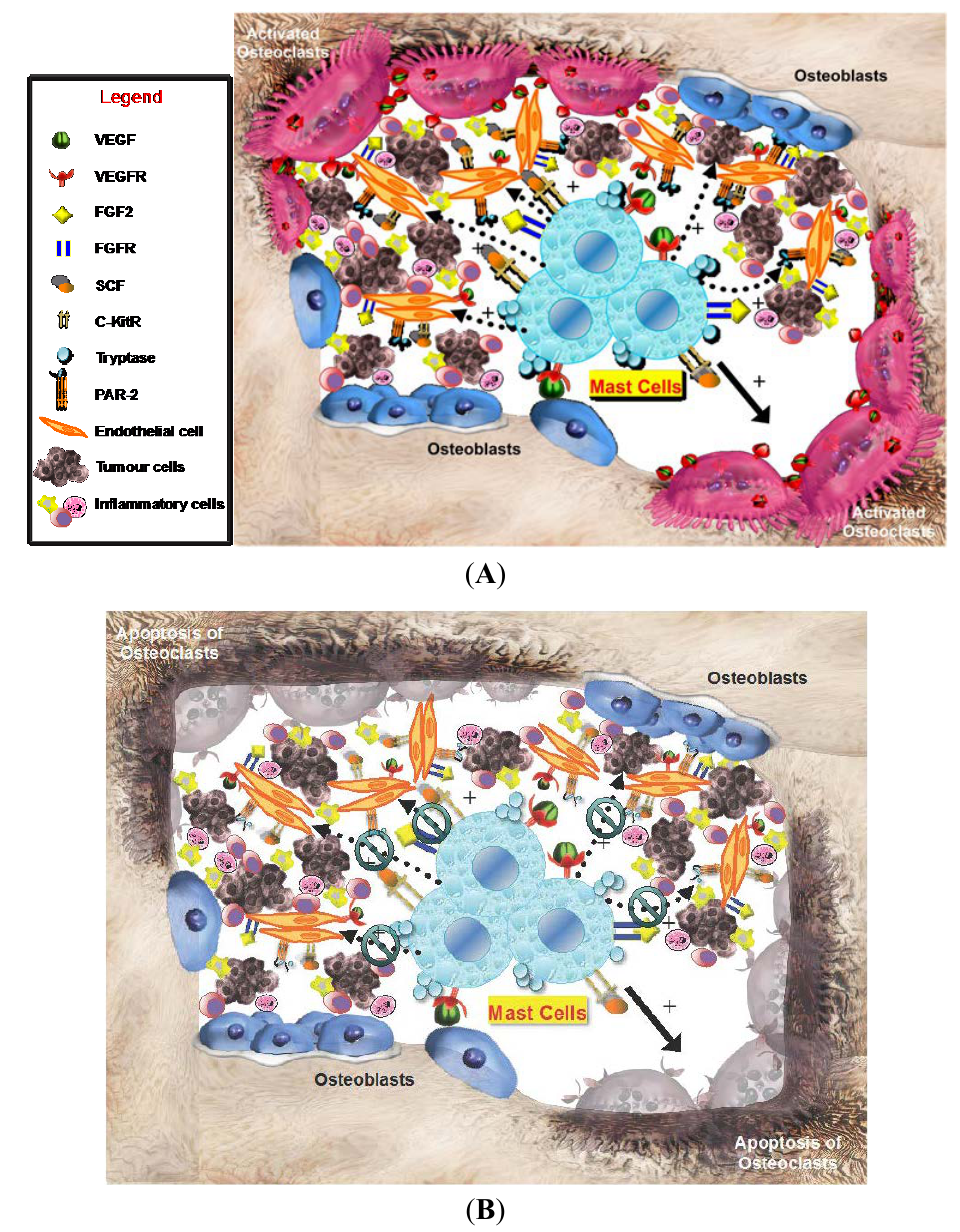
Figure 3. ( A ) The hypothetical crucial role of peritumoral MCs infiltrating surrounding gastric cancer cells in the bone microenvironment. MC degranulation, inducing the increase (see dotted arrows with +) of several pro-angiogenetic factors, such as VEGF, FGF2, SCF, and tryptase that bind or interfere with their specific receptors, expressed both by mast cells and endothelial cells, could promote osteoclast activation (see solid arrows), tumor angiogenesis, gastric cancer cell growth and; and ( B ) MCs targeting (see green symbols) in bone tumor microenvironment, i.e. , by means of tryptase inhibitors could represent a potential anti-angiogenetic strategy to inhibit osteoclast activation promoting their apoptosis and slow the progression of bone metastases. VEGF, Vascular Endothelial Growth Factor; VEGFR, Vascular Endothelial Growth Factor; FGF2, Fibroblast Growth Factor 2; FGFR, Fibroblast Growth Factor Receptor; SCF, Stem Cell Factor; c-KitR , c-Kit Receptor; PAR-2, Proteinase-Activated